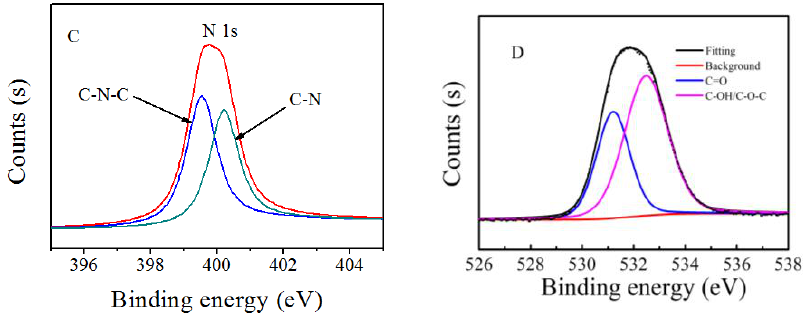
Figure 6. Survey X-ray photoelectron spectroscopy (XPS) spectra of FCNs ( A ) and high-resolution XPS data of C1s ( B ), N1s ( C ) and O1s ( D ).